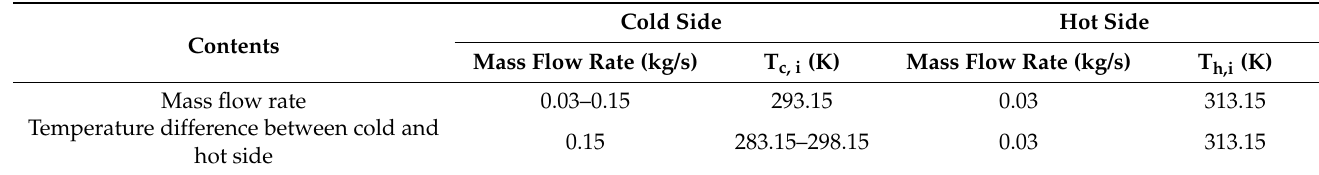
Table 1. Simulation conditions of plate heat